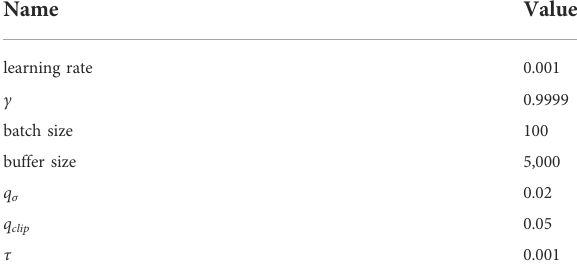
TABLE 2 Hyperparameters used for